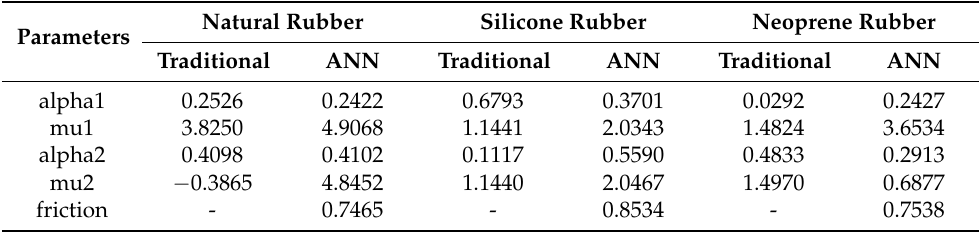
Table 3. Ogden-2 hyperelastic material parameters based on coupon tests (traditional) and component tests